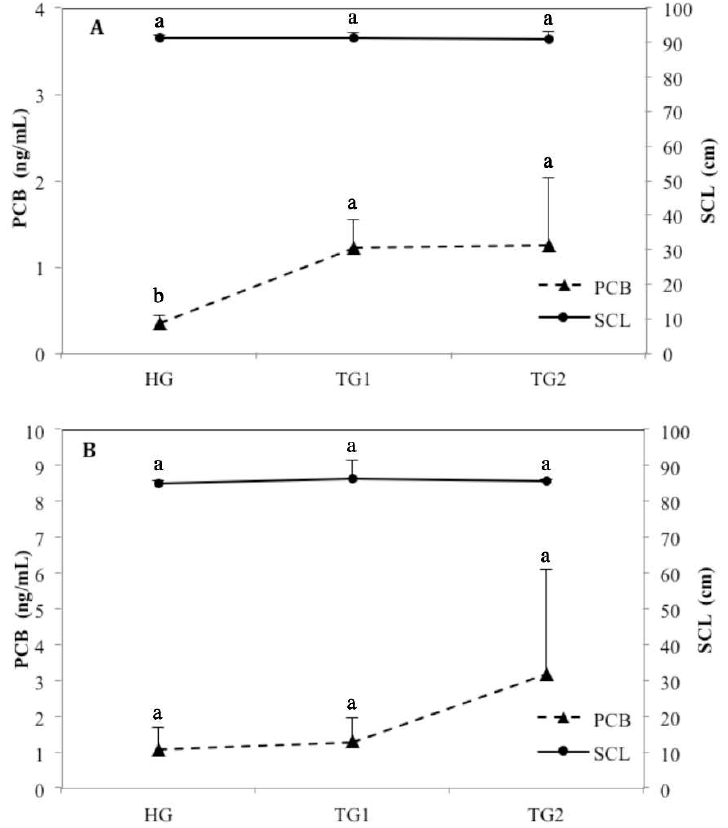
Figure 1. Tumor status and PCB concentration in the female ( A ), and male ( B ) green turtles collected from Hawaii. Data were presented as mean + standard error. Different lowercase letters indicate significant differences ( p < 0.05; Duncan’s multiple range test). (HG: healthy group; TG1: moderate afflicted group; TG2: severe afflicted group).